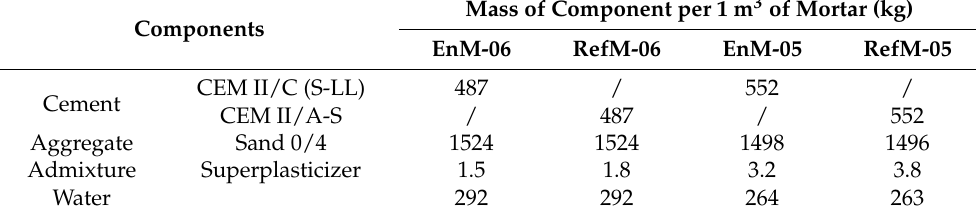
Table 1. Mortar mix design, stating the mass of components needed for 1 m 3 of mortar. EnM and RefM stand for mortar made with EnDurCrete and reference cement respectively, while the extensions -06 and -05 denote w/c